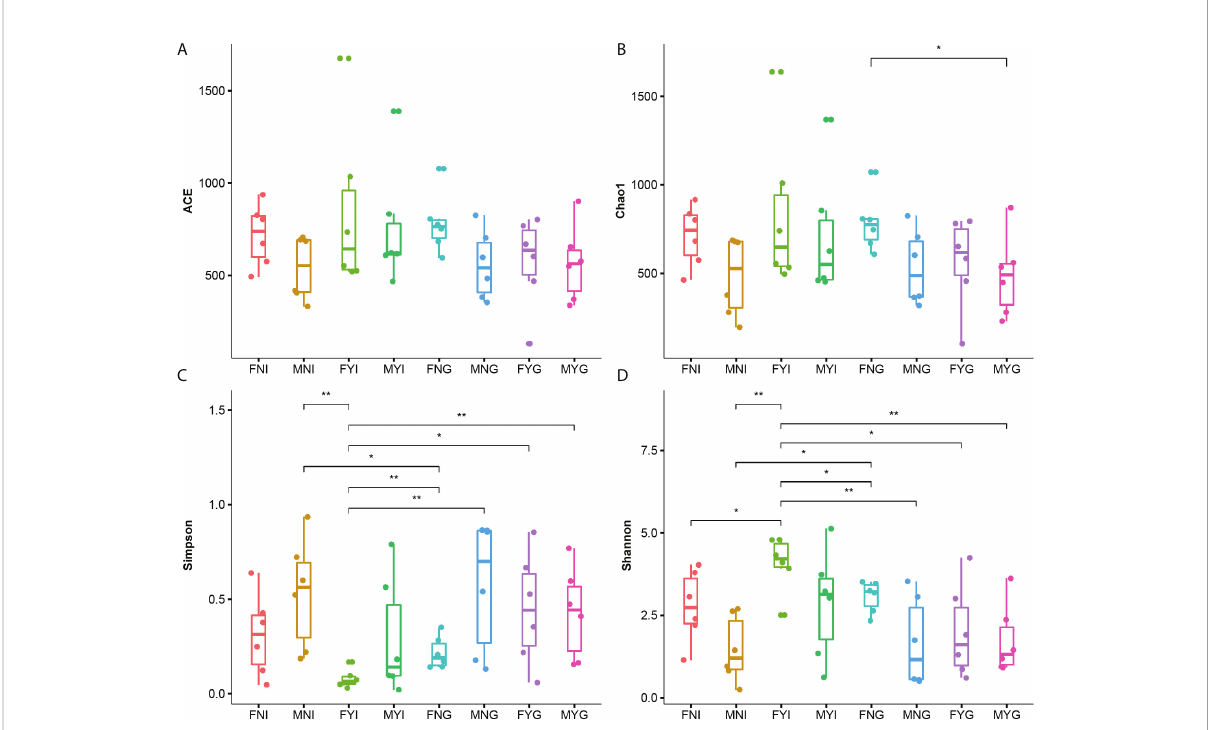
FIGURE 3 Microbial diversity indices in the intestine and gill microbial samples of medium-form populations of Sthenoteuthis oualaniensis . (A) Observed, (B) Chao1 indices, (C) Simpson indices, and (D) Shannon indices. FNI represents the intestine samples offemale immature gonad, MNI represents the intestine samples of male immature gonad, FYI represents the intestine samples of female sexual maturity, and MYI represents the intestine samples of male sexual maturity, FNG represents the gill samples of female immature gonad, MNG represents the gill samples of male immature gonad, FYG represents the gill samples offemale sexual maturity, and MYG represents the gill samples of male sexual maturity. *Indicates the signi fi cant difference between two samples (p < 0.05) and **indicates the extremely signi fi cant difference between two samples (p <